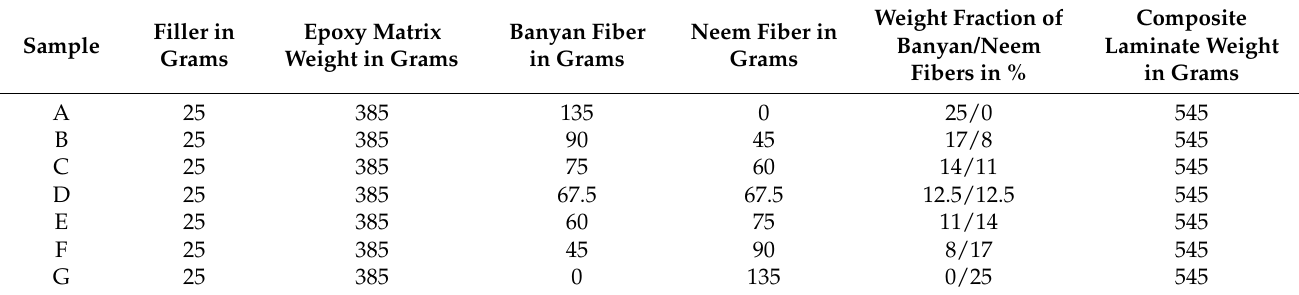
Table 1. The weight concentration of the hybrid epoxy